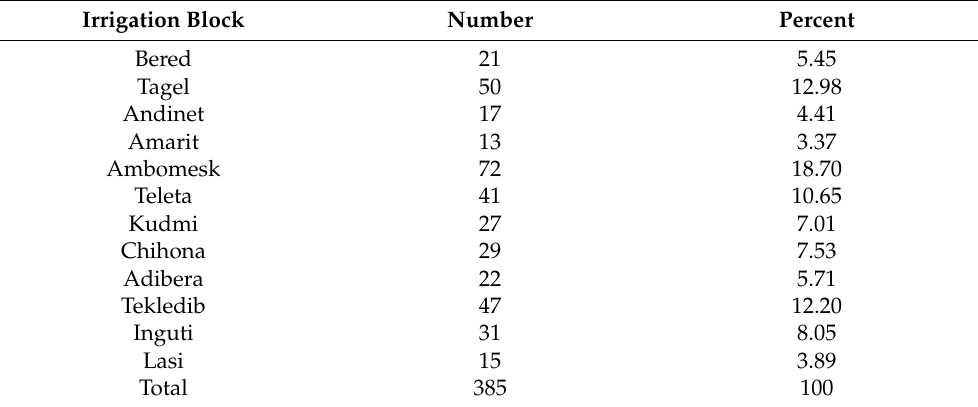
Table 1. The distribution of sample HHs in the irrigation